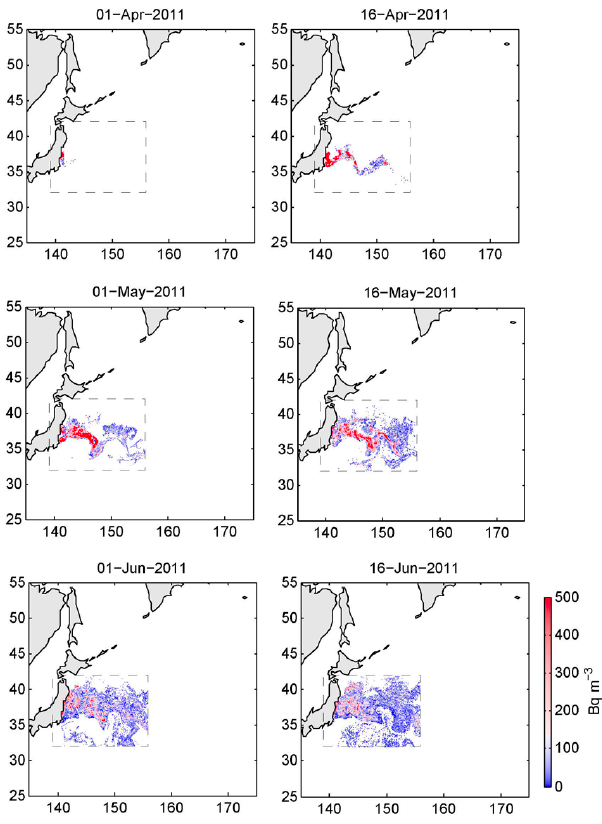
Fig. 10. Modeled 137 Cs concentration within the mixed layer on 137 Cs concentration within the mixed layer on select dates from the Fig. 10. Modeled select dates from the oceanic source using 2-D NCOM velocities oceanic source using 2-D NCOM velocities averaged over the top 25 meters. Dashed lines show the modeled domain. Source characteristics as in Fig. 3. averaged over the top 25m. Dashed lines show the modeled domain. Source characteristics as in Fig.